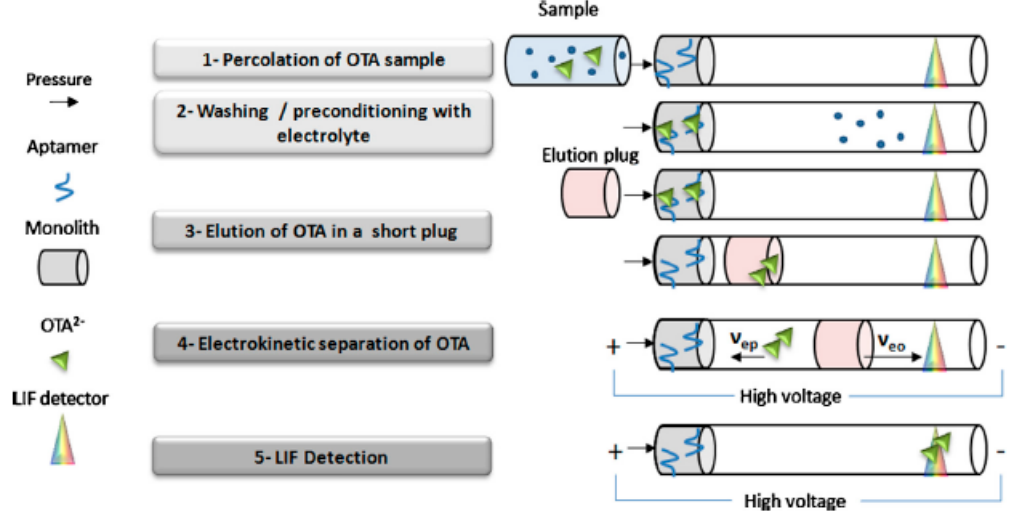
Figure 3. Inline aptamer affinity CE in OTA analysis. In the image, the complete procedure is described. 1. Percolation step: OTA(-cations species) is solubilized in binding buffer and percolated through the column with aptamers; 2. Washing: OTA is bound to aptamers, while unbound analytes and binding buffer are flushed away by the separation buffer (the presence of ions maintain the complex OTA-aptamers); 3. Elution: OTA is desorbed by injecting an elution plug (plug length must be >than 10% the monolith length); 4. Electrokinetic separation: OTA is separated by voltage. 5. Detection: OTA reaches Laser-Induced Fluorescence (LIF). (Reproduced with permission from Marechal, Journal of Chromatography A ; published by Elsevier, 2015 [41]).